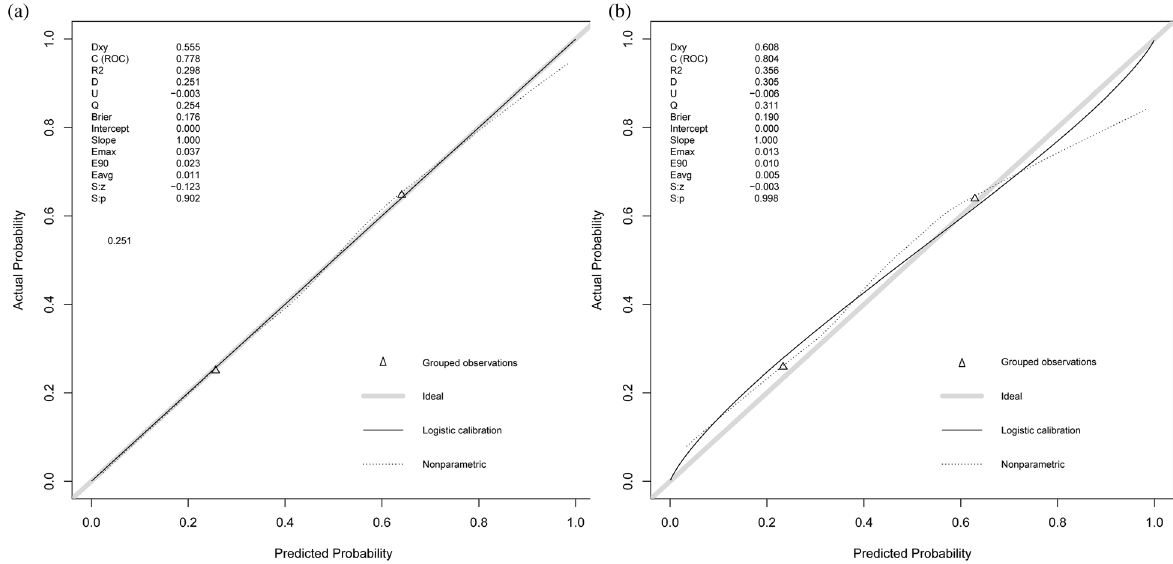
Figure 5. The calibration curve of the nomogram. ( a ) Training set; ( b ) validation set.